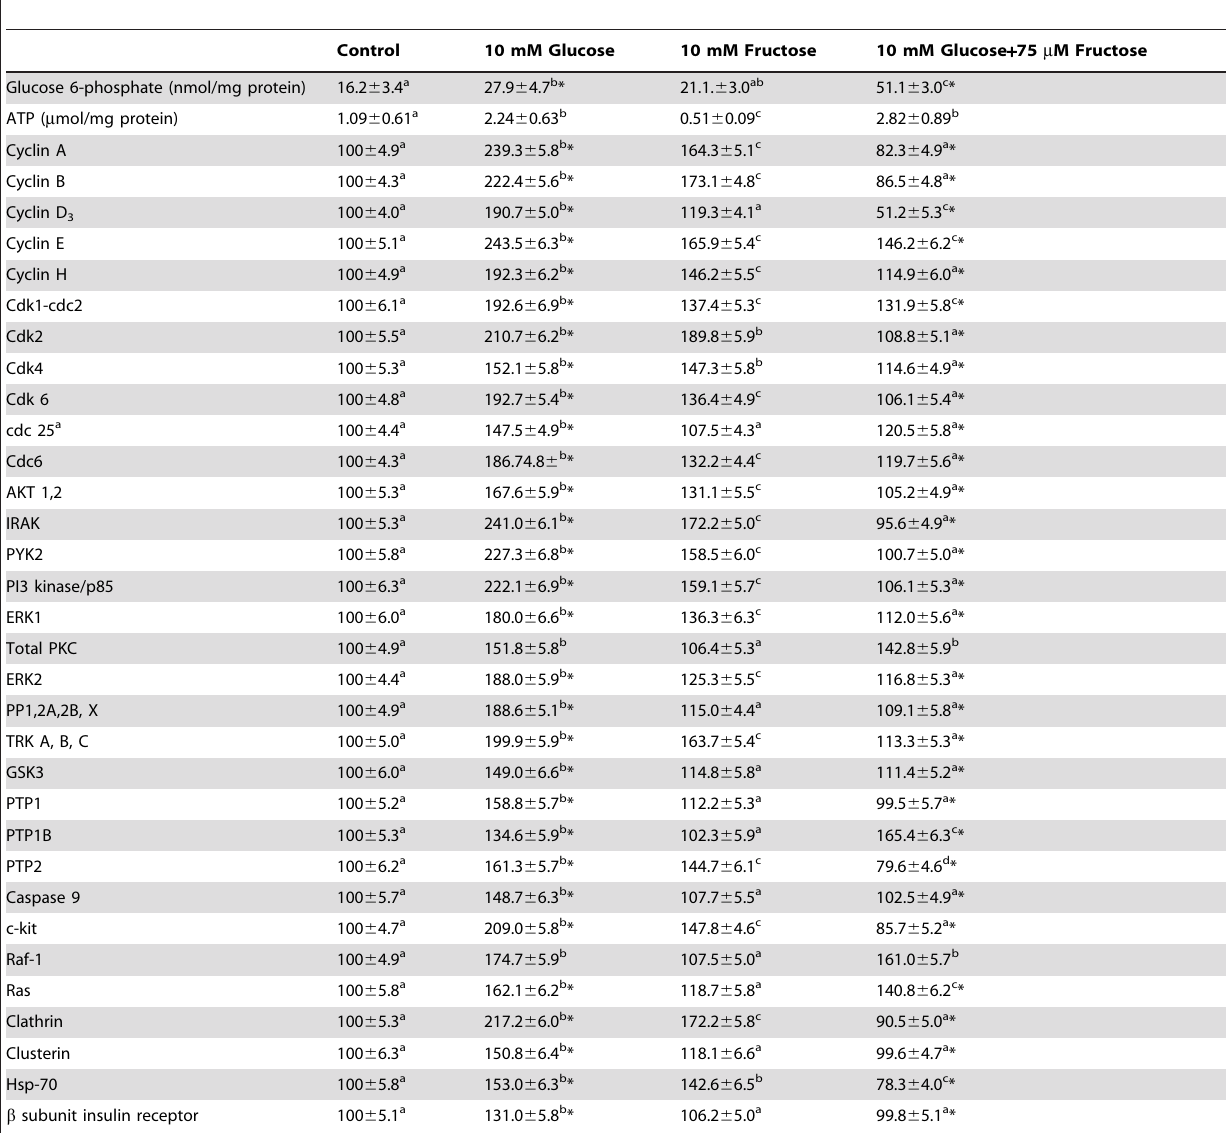
Table 4. Intracellular glucose 6-phosphate and ATP levels and relative increase in serine phosphorylation levels of selected proteins of hepatocytes incubated in the presence or absence of glucose or fructose.